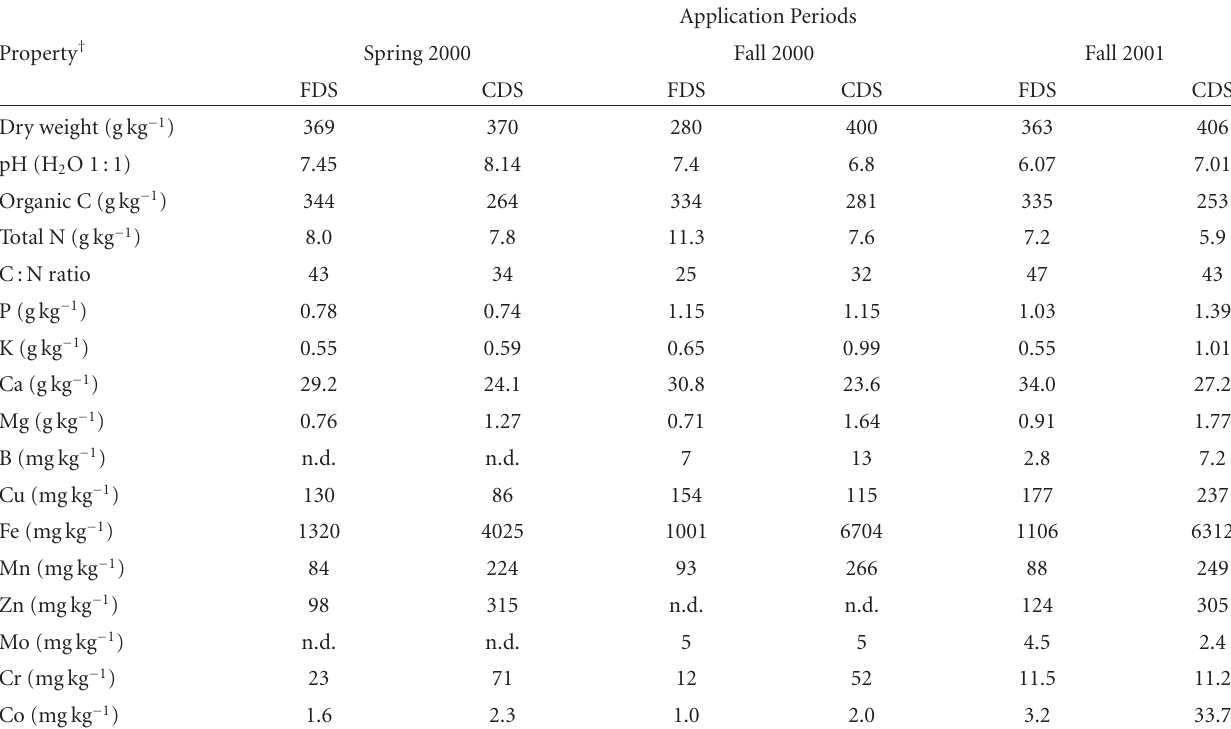
† Elements listed are expressed on dry weight basis. n . d . = not detected